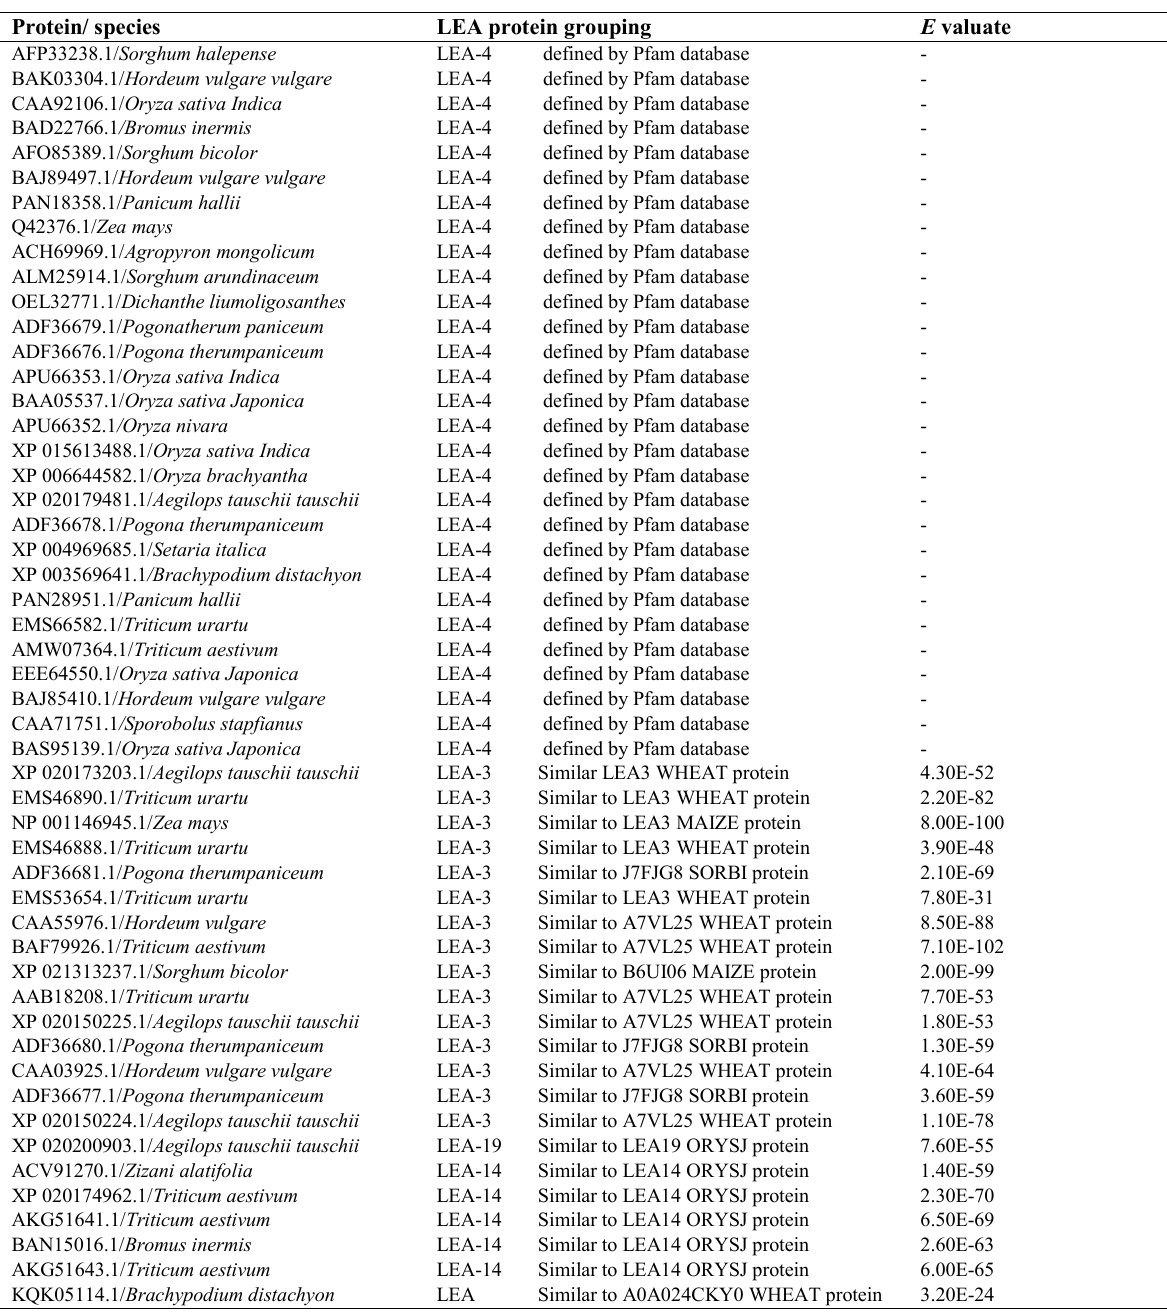
Table 2 : Continued Protein/